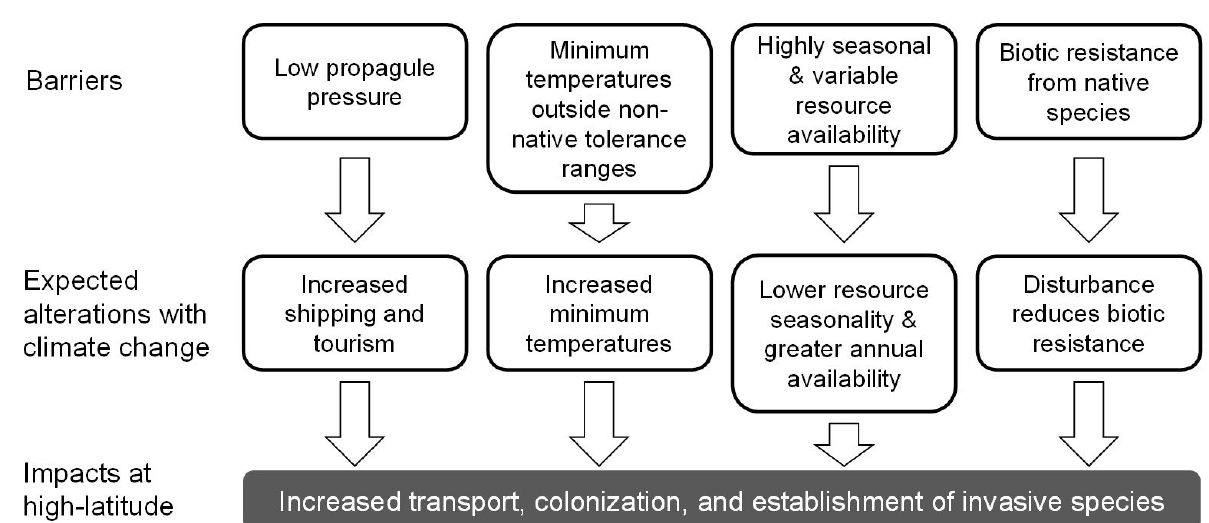
Figure 1. Climate change is likely to increase the invasion of high-latitude ecosystems by breaking down existing invasion barriers across the invasion pathway, from transport to colonization and